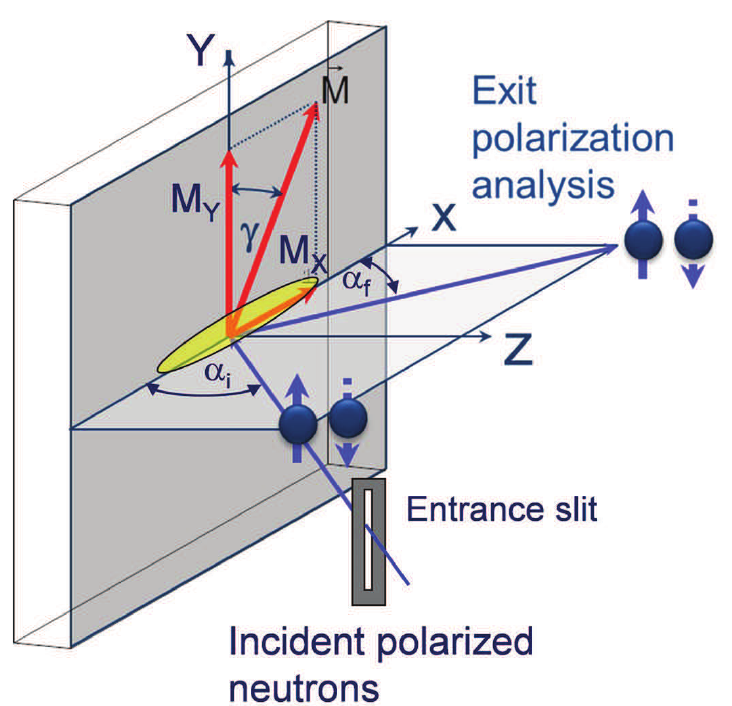
Figure 1. Sketch of the sample and beam geometry for polarized neutron reflectometry (PNR) experiments with one-dimensional polarization analysis along the Y -axis. The elongated ellipsoid indicates the coherence volume of neutrons defined by the beam divergence and the wavelength